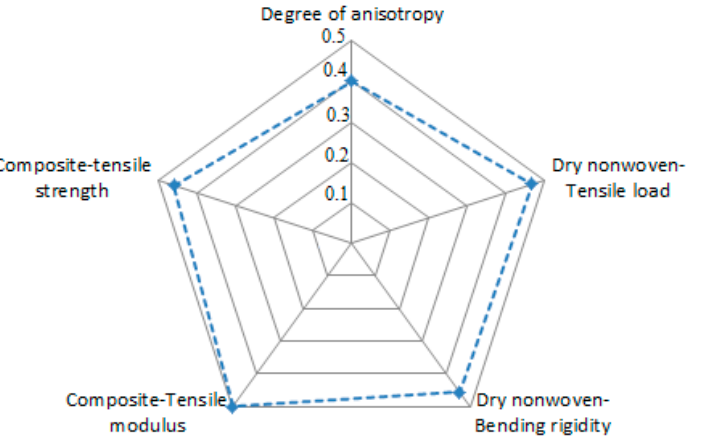
Figure 11. Anisotropy index and ratios characterising parameters between the two main directions (MD and CD) of the nonwoven material.